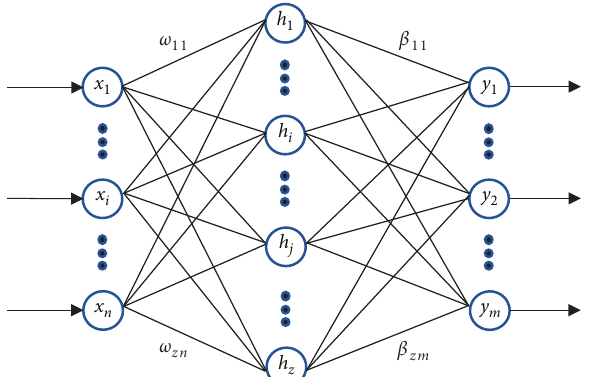
Figure 2: Schematic diagram of a single-hidden layer.